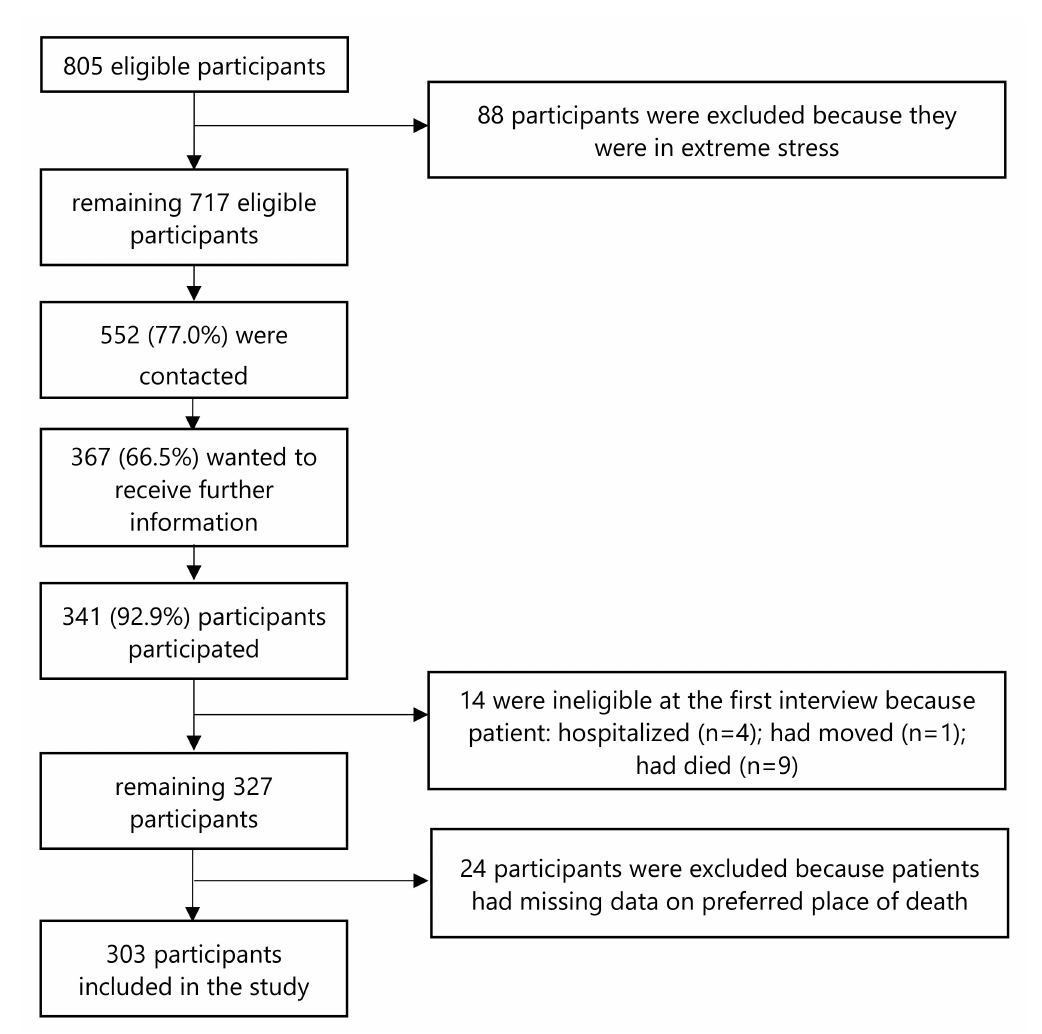
Figure 1. Diagram of inclusion/exclusion criteria of the